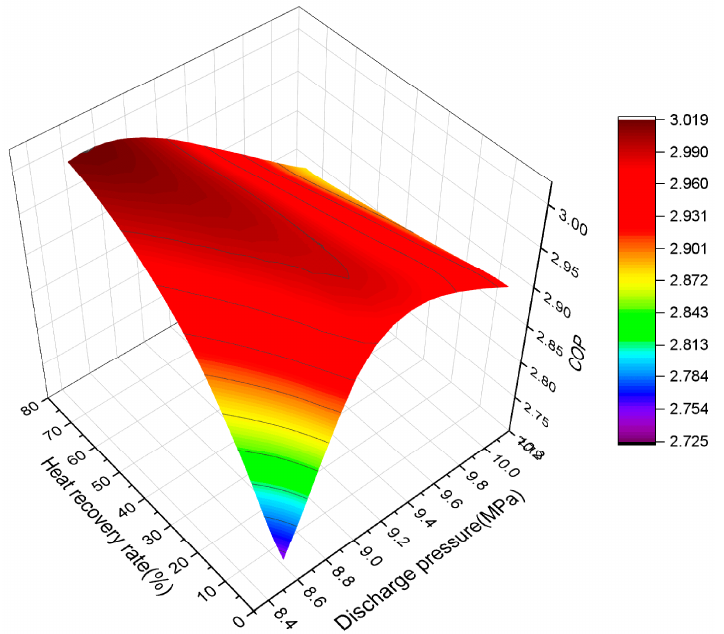
Figure 8. The collaborative optimization of the discharge pressure and heat recovery rate under − 10 °C in ambient temperature.